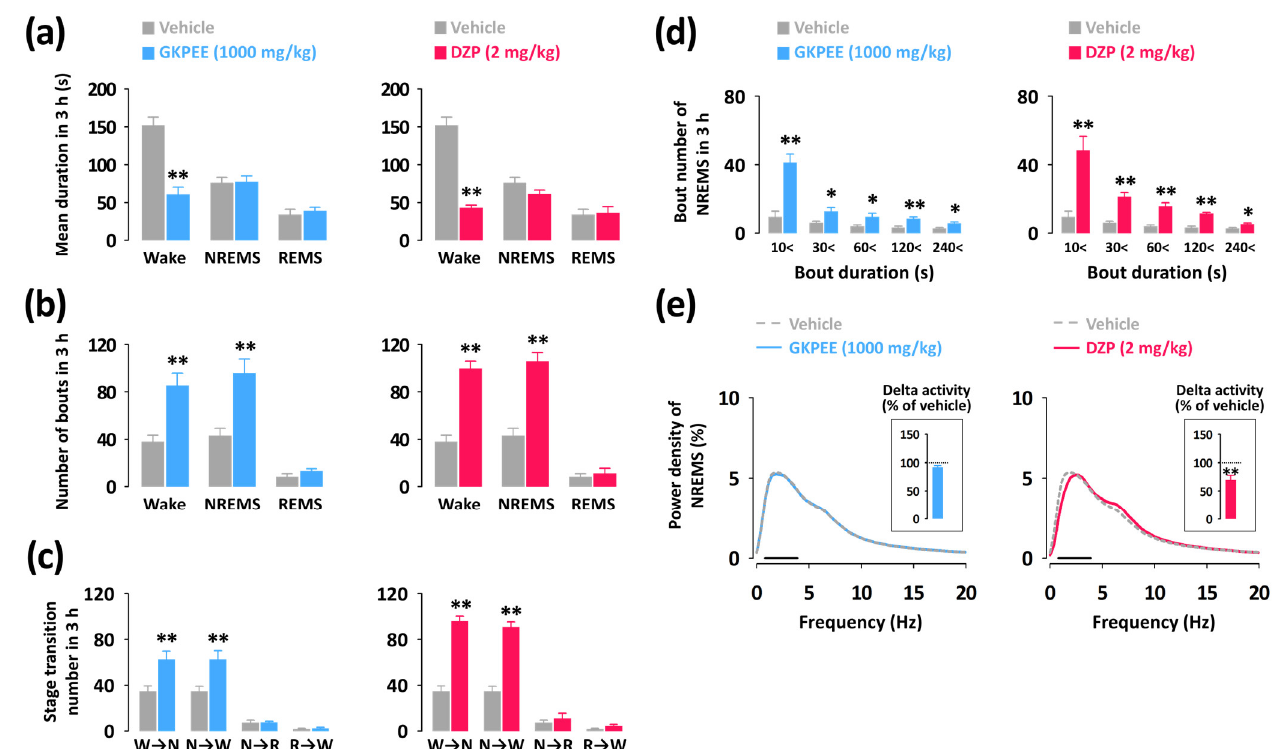
Figure 4. Effects of GKPEE and DZP on sleep-wake episodes in mice during the 3 h period after injection. ( a ) Mean duration and ( b ) total number of Wake, NREMS, and REMS bouts in a 3 h period after the administration of GKPEE and DZP. ( c ) Sleep-wake stage transitions during the 3 h following administration of GKPEE and DZP. ( d ) Changes in the number of NREMS bouts of different bout duration in C57BL/6N mice following administration of GKPEE or DZP. Columns represent the mean ± SEM of 7–8 mice. ( e ) EEG power density curves of NREMS caused by GKPEE and DZP. The bar (—) represents the range of the delta wave (0.5–4 Hz). * p < 0.05, ** p < 0.01 were considered significant as compared to the vehicle (paired Student’s t-test). DZP, diazepam; GKPEE, green kiwifruit peel ethanol extract; NS, no significance; REMS (or R), rapid eye movement sleep; NREMS (or N), non-REMS; SEM, standard error of mean; Wake (or W), wakefulness.